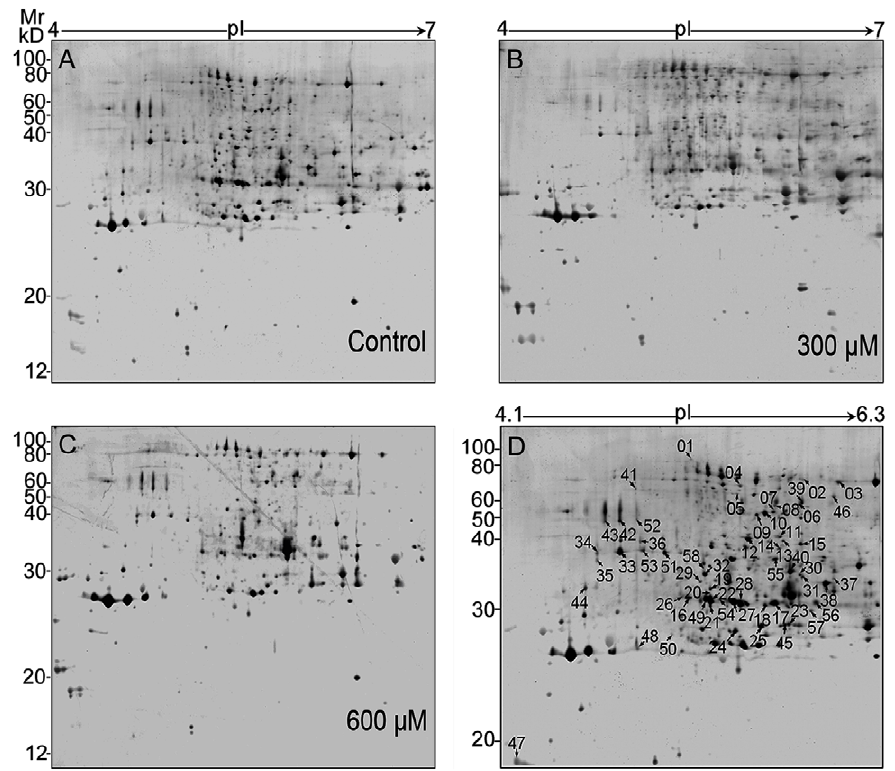
Figure 2. 2-DE image analysis of rice root apoplast proteome under H 2 O 2 treatments. (A–C) Set of three gels corresponding to apoplast protein samples treated with 0 (A), 300 (B), and 600 m M (C)of H 2 O 2 . (D) A representative gel showing the identified differentially expressed protein spots. 200 m g of the protein sample was loaded onto 24 cm IPG strips, pH 4–7 and electrophoresed as described in the text. The gel (12.5%) was stained using a mass spectrometry compatible silver staining method. A total of 58 protein spots were expressed differentially in response to the oxidative treatments, with p , 0.05. Among these, 54 spots corresponding to 35 proteins are listed in Table S1.